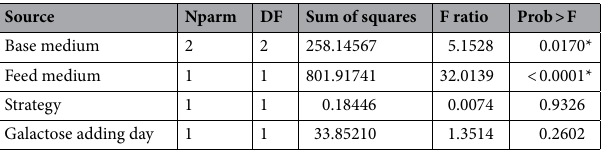
Table 2. Analysis of four factors effecting on glycan similarity using distance value as the response. * Significant when P is less than 0.05.